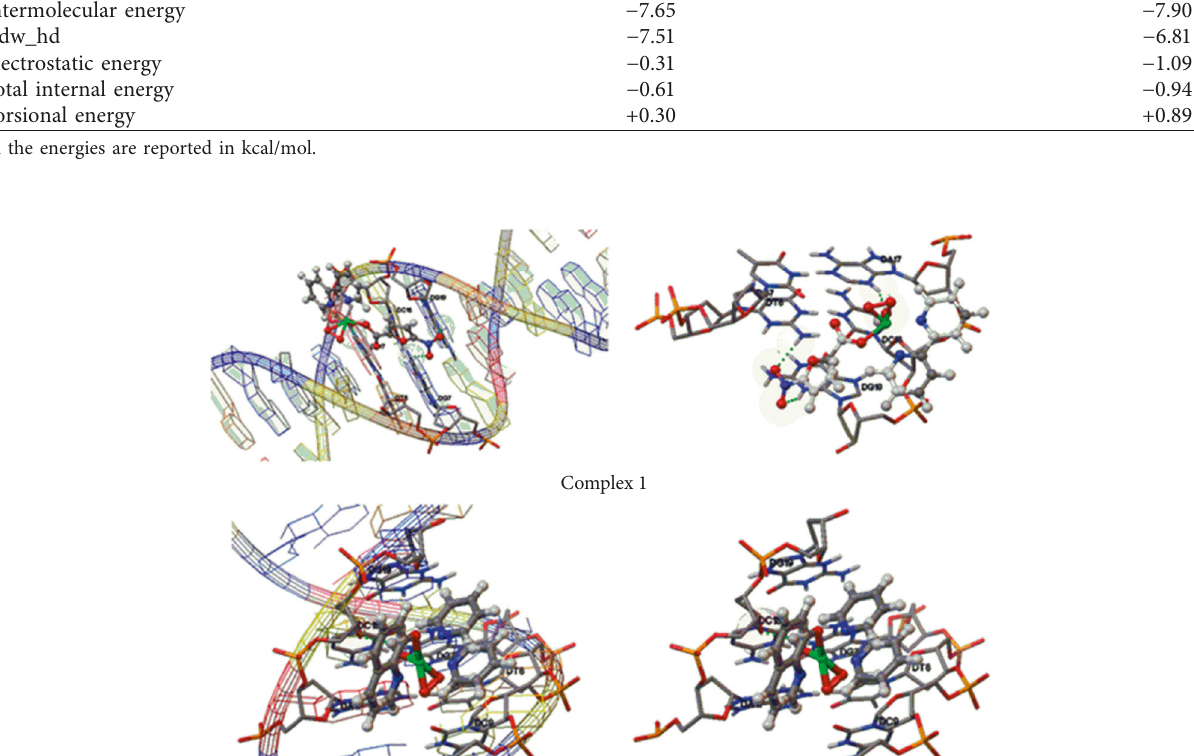
Table 6: The binding ( ∆ G Parameter (kcal/mol)